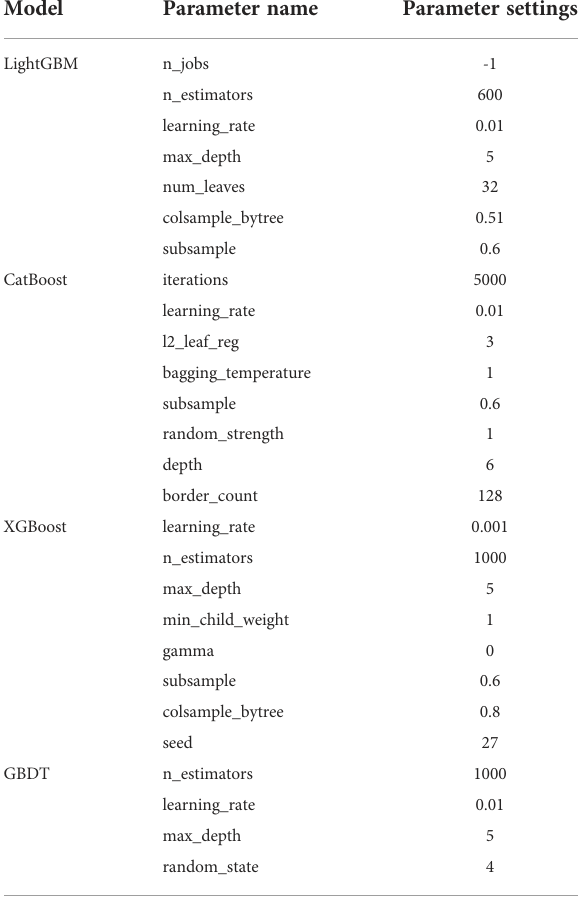
TABLE 3 Key parameter settings for each ensemble learning model.